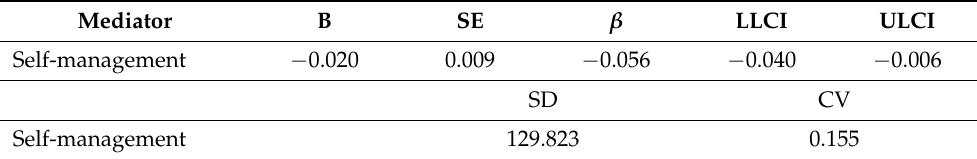
Table 9. Analysis of the moderated